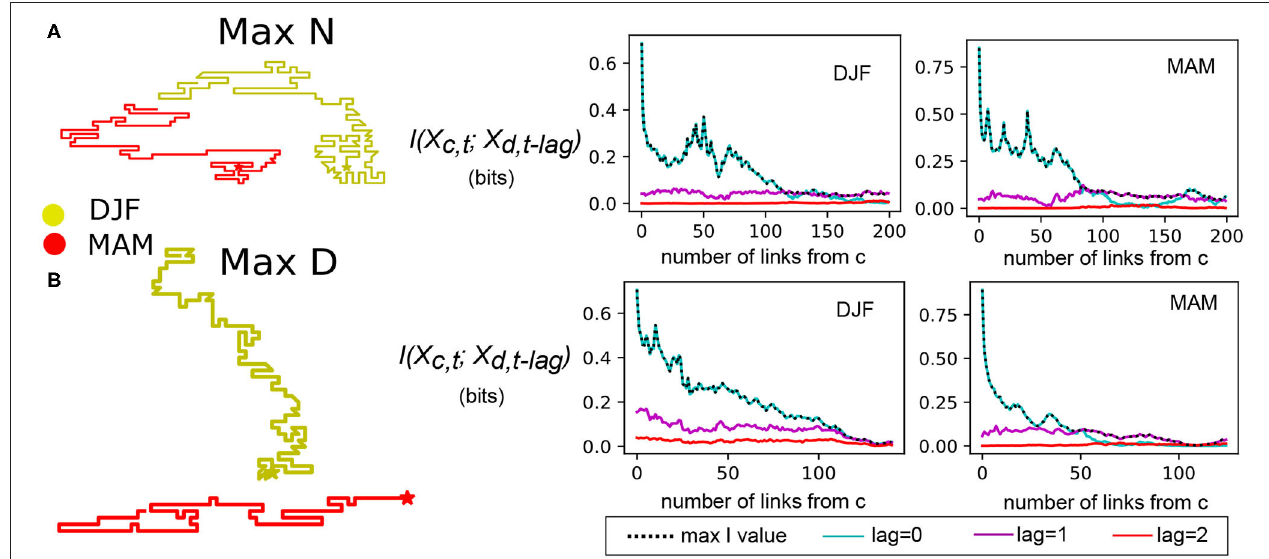
FIGURE 4 | Mutual information values associated with maximum N and maximum D example cases from Figure 3 . (A) Instantaneous (lag 0), 1 day lag, and 2 day lag mutual information between each grid cell along chain and the original center location for winter and spring locations associated with maximum number of links. (B) Same as (A) for locations associated with maximum geographic distance between central point and end point.